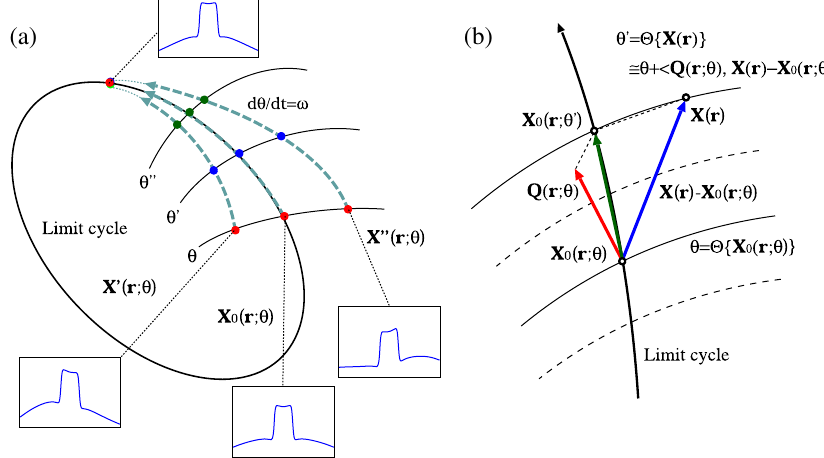
FIG. 6. (a) Isochrons of a limit-cycle solution of a reaction-diffusion system. The same phase value is assigned to the system states (represented by vector fields) that asymptotically converge to the same state on the limit-cycle solution. (b) Linear approximation of the phase near the limit-cycle